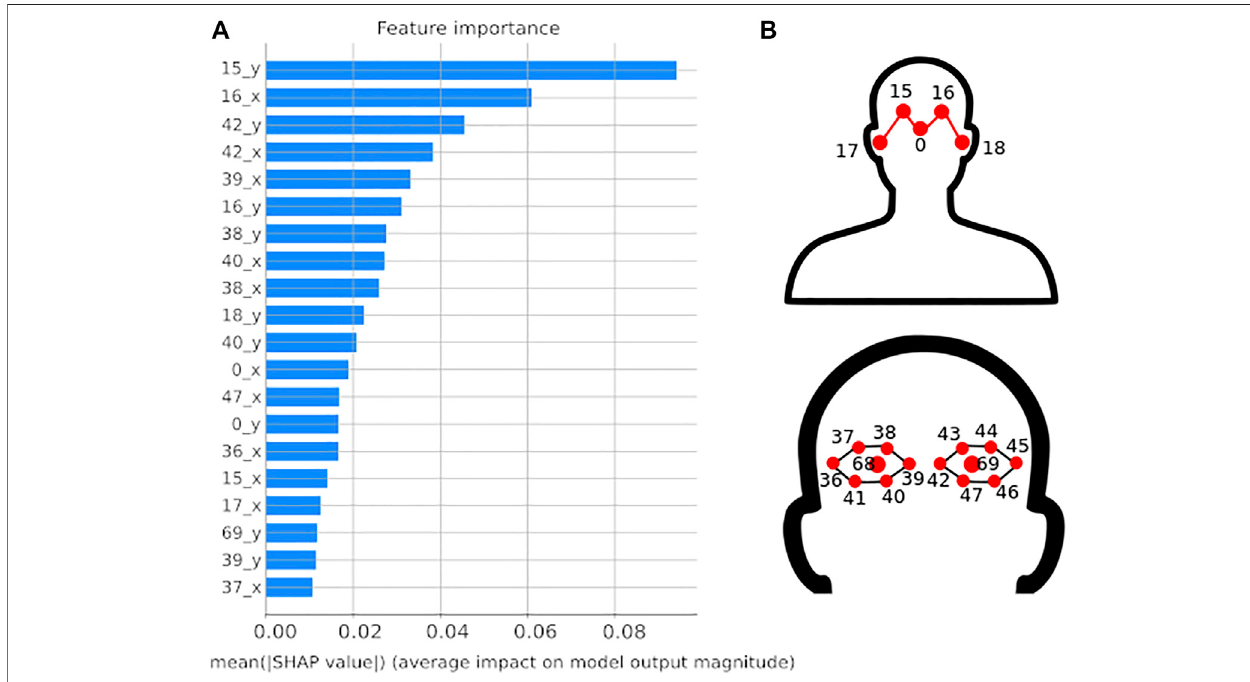
FIGURE 3 | Feature importance. (A) Bar plot reporting on the x -axis the SHAP feature importance in percentage measured as the mean absolute Shapley value. Only the fi rst 20 most important features are reported on the y -axis. (B) Numbered face keypoints of the feature vector.